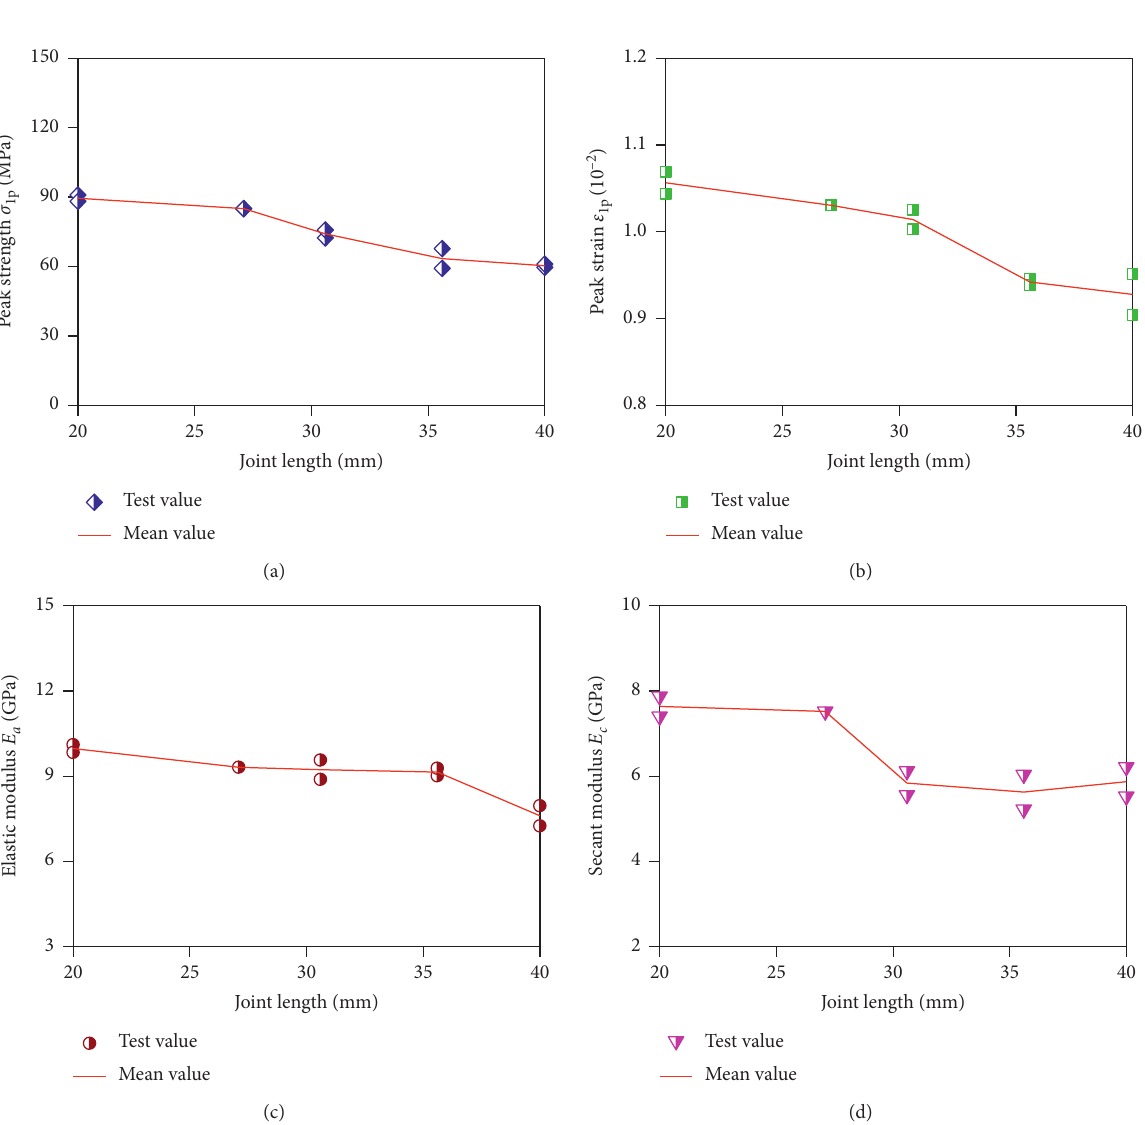
Figure 8: Effects of joint length on (a) peak strength, (b) peak strain, (c) elastic modulus, and (d) secant modulus of specimens, respectively ( α � 60 °